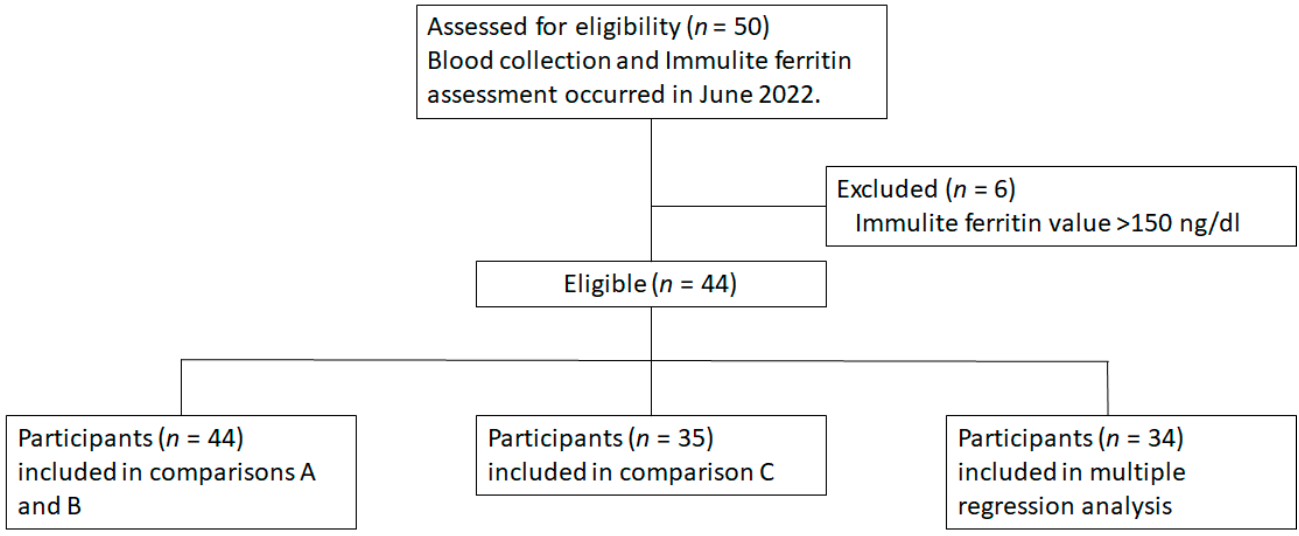
Figure 1. CONSORT diagram showing the inclusion and exclusion criteria and the resulting eligible participants, whose blood samples were further subdivided and analysed based on blood collection methods obtained during the data collection periods.